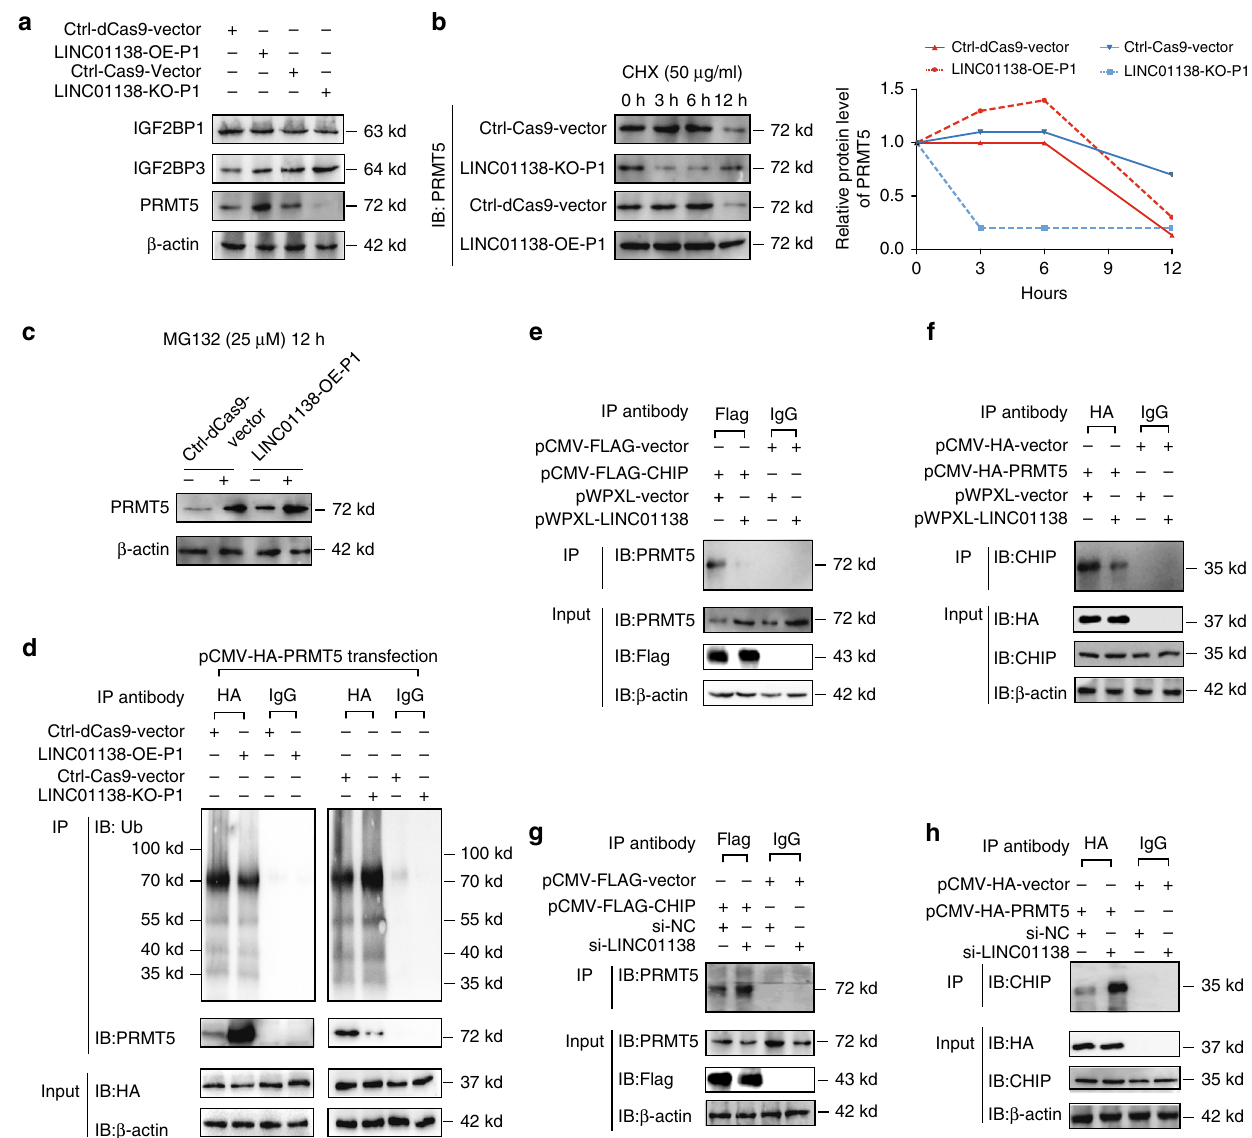
Fig. 4 LINC01138 blocks ubiquitin/proteasome-dependent PRMT5 degradation. a Immunoblotting for the protein levels of IGF2BP1, IGF2BP3 and PRMT5 after LINC01138 activation or knockout. β -actin served as the internal control. b LINC01138-KO cells, LINC01138-OE cells, or the control cells were treated with cycloheximide (CHX, 50 μ g/ml) for the indicated times. Left, immunoblotting for the PRMT5 levels in whole-cell extracts; right, the densitometry analysis of the PRMT5 protein levels; the relative fold of the level at 0 h. c LINC01138-OE or vector cells were treated with MG132 (25 μ M) for 12 h. Immunoblotting for PRMT5 levels in the indicated cells. d LINC01138-KO or LINC01138-OE cells were transfected with pCMV-HA-PRMT5 plasmids for 48 h. The cell lysates were immunoprecipitated (IP) with either control IgG or HA antibody and immunoblotted with the ubiquitin-speci fi c antibody. HA- tagged PRMT5 and β -actin served as the loading control. e – h Immunoprecipitation to detect the association between PRMT5 and CHIP after LINC01138 overexpression or knockdown. pCMV-HA-PRMT5 plasmid and pCMV-Flag-CHIP plasmid were co-transfected into pWPXL-LINC01138 or pWPXL-Vector SMMC-7721 cells ( e , f ) and si-NC or si-LINC01138 SMMC-7721 cells ( g , h ) for 48 h. FLAG-tagged CHIP, HA-tagged PRMT5 and β -actin served as